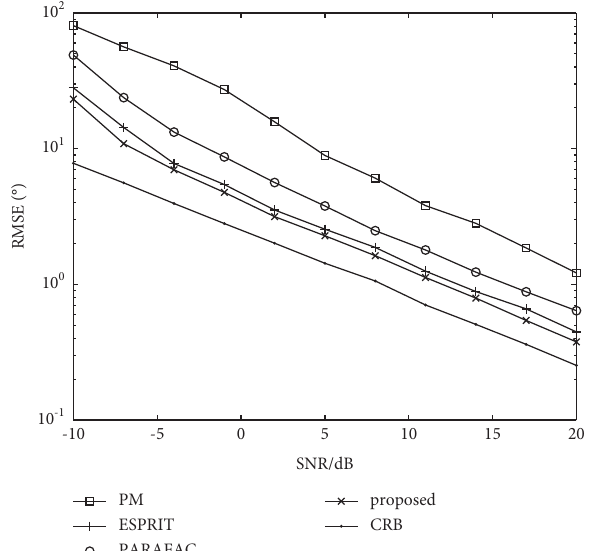
Figure 8: η estimation of different algorithms versus SNR.